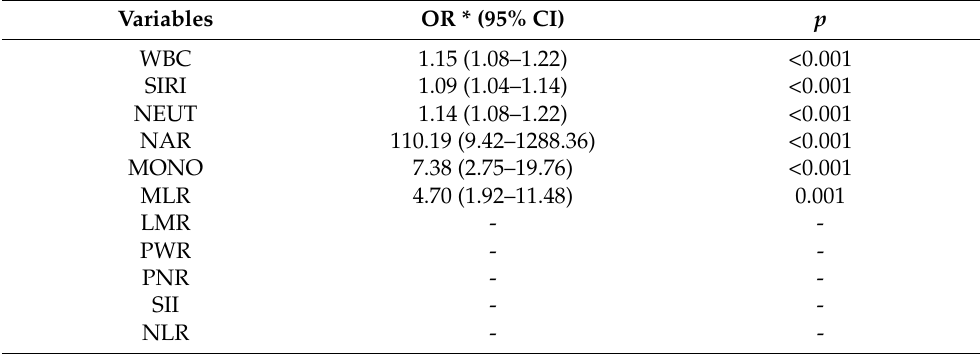
Table 2. Multivariate analysis results of inflammatory biomarkers after adjusting for age, hy- pertension, WFNS grade 4–5, mFS grade 3–4, a Graeb score of 5–12, acute hydrocephalus, and treatment